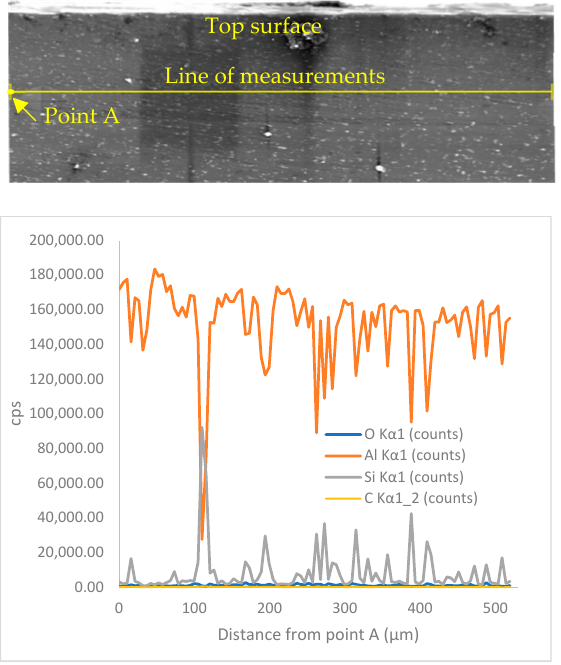
Figure 9. Horizontal line EDS spectrum of surface composite measured at 100 μ m below top surface.